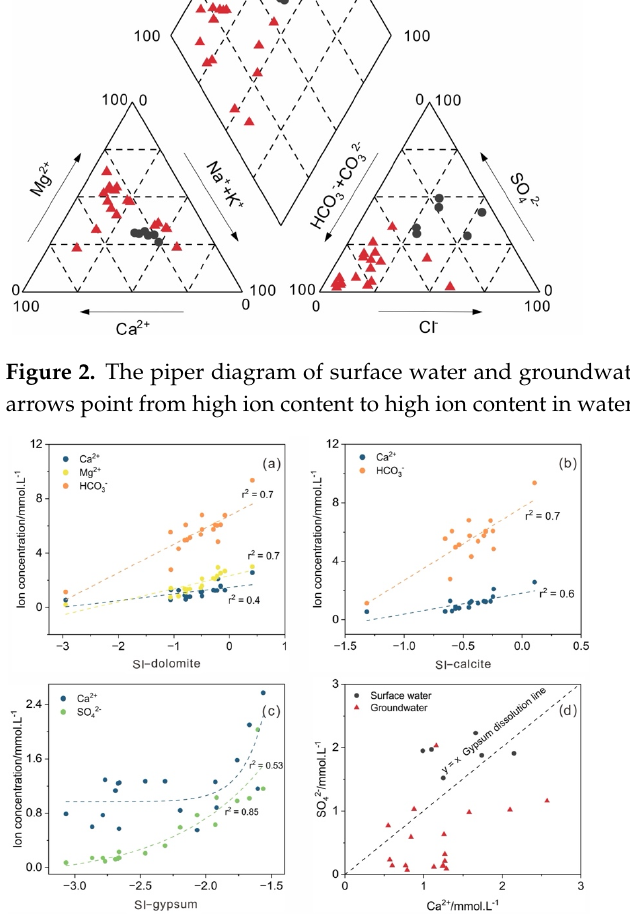
Figure 3. Relationship diagrams for major ions in surface water and groundwater samples: ( a ) correlations of SI − dolomite and related ions; ( b ) correlations of SI − calcite and related ions; ( c ) correlations of SI − gypsum and related ions; ( d ) scatter plot of Ca 2+ and SO 42 −